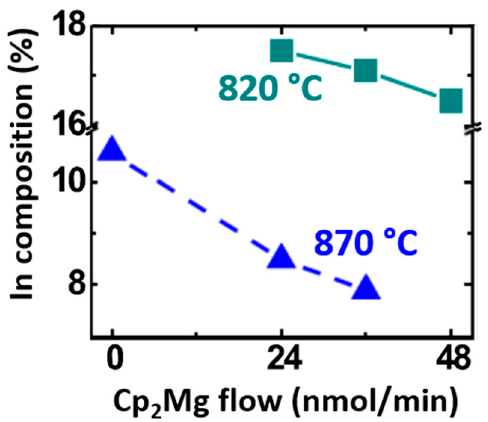
Figure 6. In composition as a function of Mg precursor flow at two different growth temperatures.